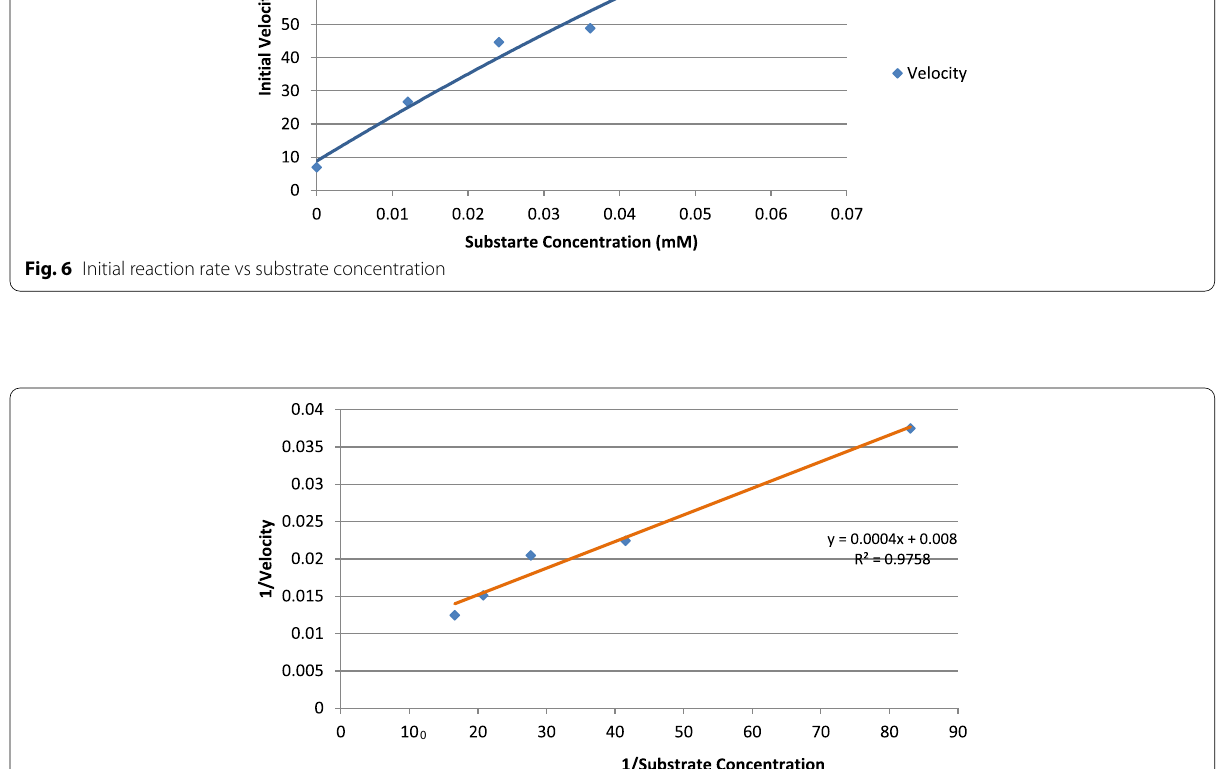
Fig. 7 Lineweaver-Burk plot for the determination of K m and V